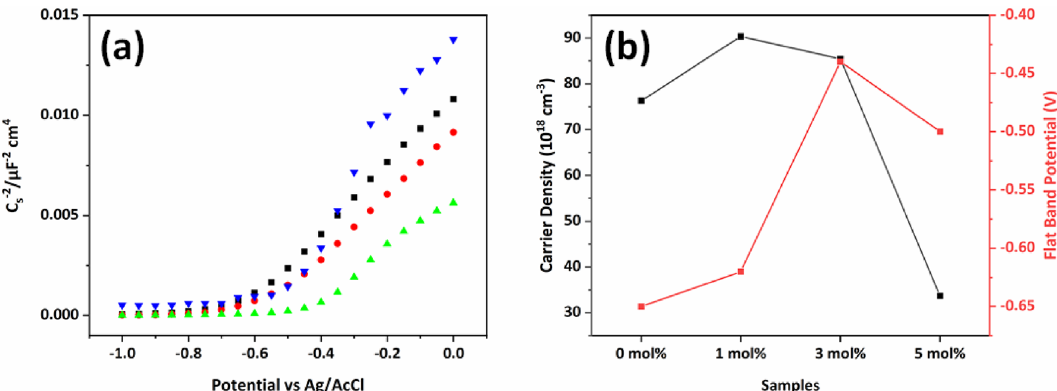
Figure 7. ( a ) Mott-Schottky plots for Cu 2+ ion doped hematite thin films with pristine (black), 1 mol% (red), 3 mol% (green), and 5 mol% (blue). ( b ) Calculated carrier density and flat band potential value from Mott- Schottky